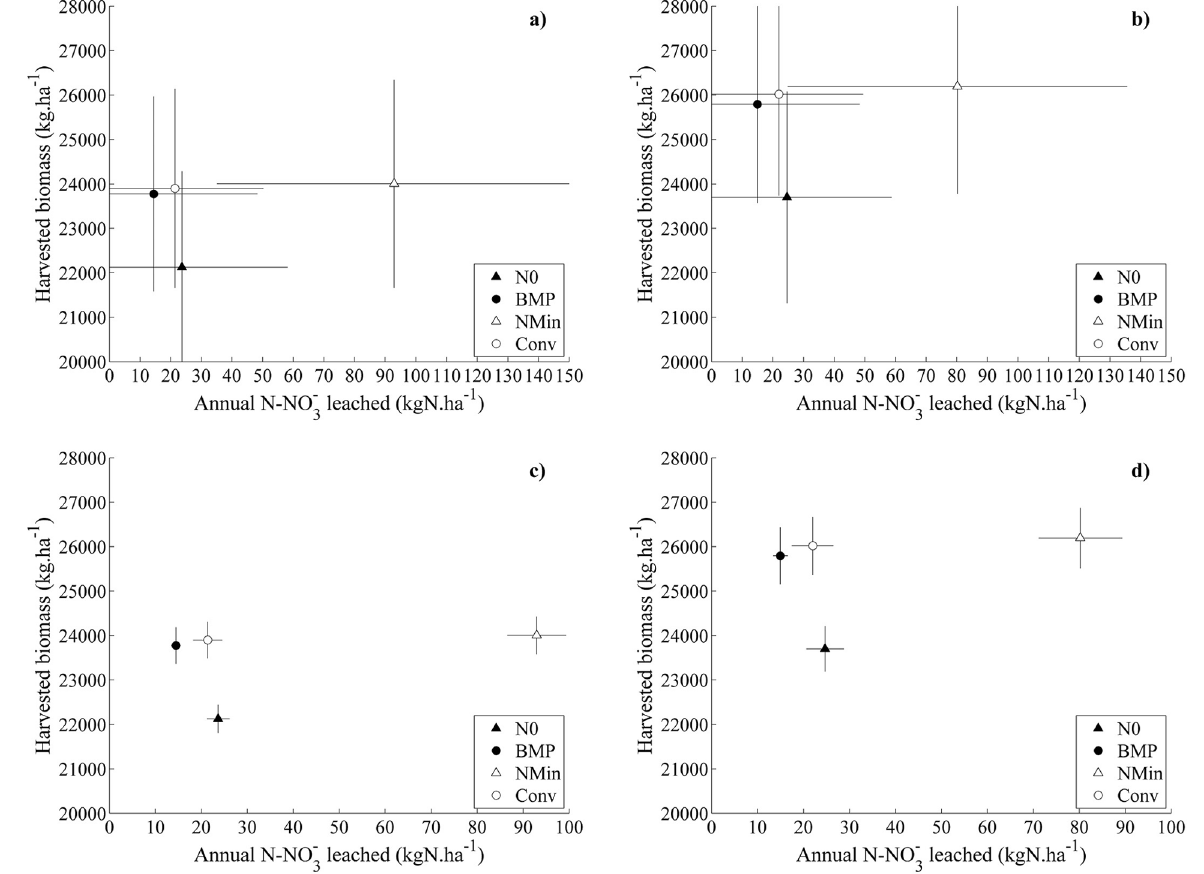
Fig 7. Inter-annual variability and inter-GCMs variability associated to nitrate leaching and harvested biomass. Average annual nitrate leached and harvest biomass for maize for the NMIN (open triangle), CONV (open circle), N0 (filled triangle) and BMP (filled circle) treatments in the long term rotation (2020 – 2073). Fig7a and b shows the inter-year variability when GCMs simulations are averaged. Fig7c and d shows the variability over the GCMs when average are computed over years. Fig7a and c refer to RCP6.0 scenario, while Fig7b and d refer to